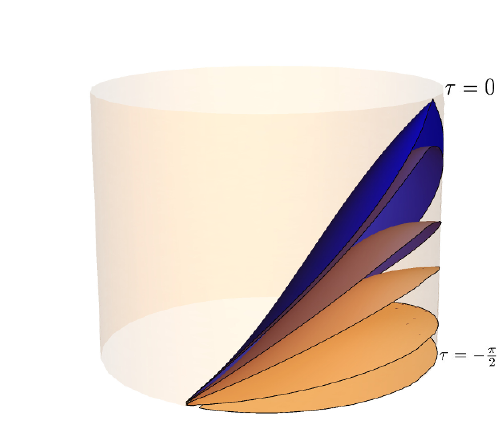
Figure 5 . Embedding of BTZ coordinate time slices into AdS 3 cylinder. The blue surface is the horizon, which coincides with the t = 1 time